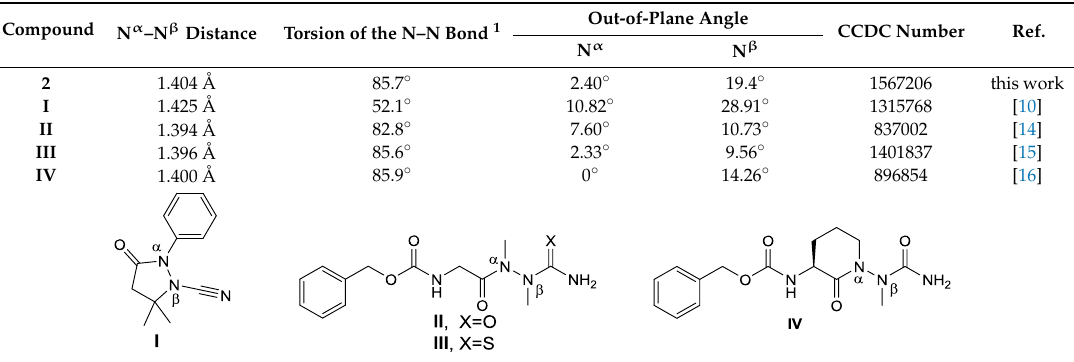
1 Defined as angle between the planes defined by each nitrogen atom and the adjacent carbon atoms.